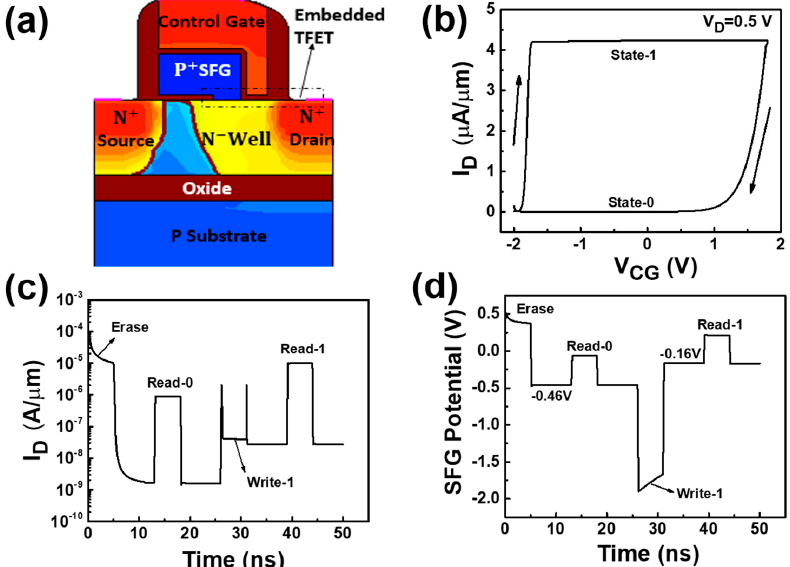
Figure 2. ( a ) Doping the concentration distribution of the SFG transistor based on an SOI substrate. ( b ) Low-speed hysteresis transfer curve of the device. ( c ) The normalized reading and writing operation currents of the device. ( d ) Changes in the SFG potential during one